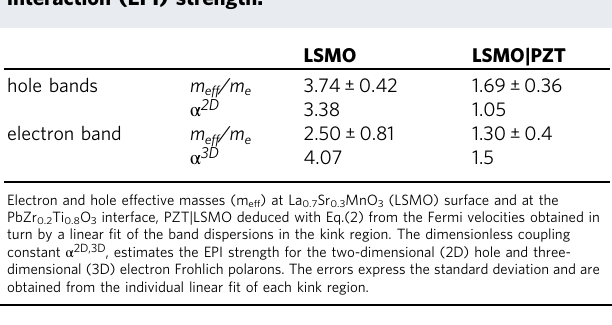
Table 2 Mass renormalization and the electron-phonon interaction (EPI)